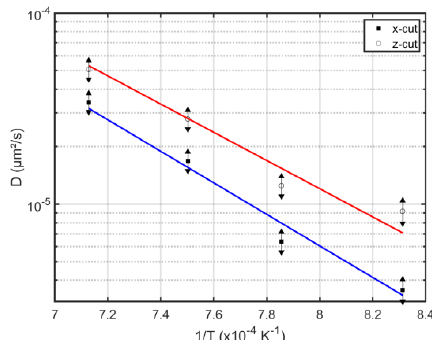
Figure 5. Arrhenius plot of the diffusion coefficients of Yb in LiNbO 3 for diffusion parallel to the x- and z-axis. The fitted lines correspond to Equation (7). z-axis. The fitted lines correspond to Equation Table 2. Diffusion constants and activation energies for Yb diffusion in LiNbO 3 .